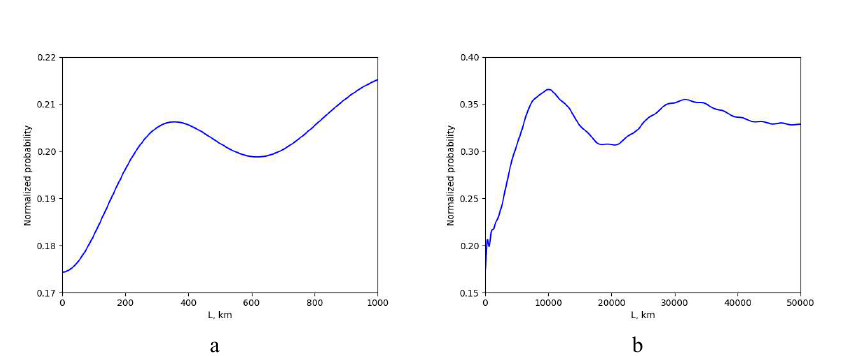
Figure 3. Normalized probability of the neutrino oscillation process with the detection by an electron on the spatial scales a) 1000 km and b) 50000 km